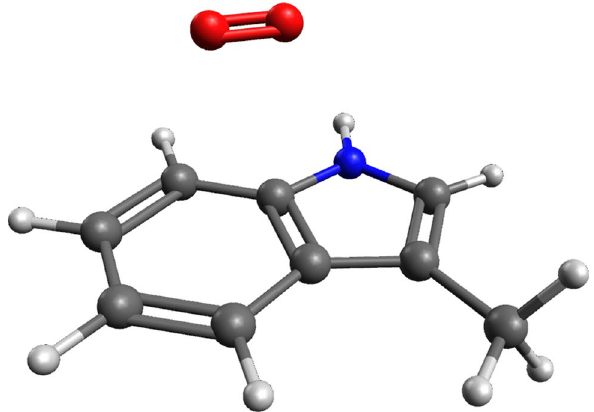
Figure 1. Schematic presentation of TrpH . + [the aromatic molecule] and O2 . − [the red molecule] radical pair, considered in the RPM model in the present work, similar to Ref. 13 . The radical pair undergoes interconversion between singlet and triplet states. Image rendered using Avogadro (https:// avoga dro.